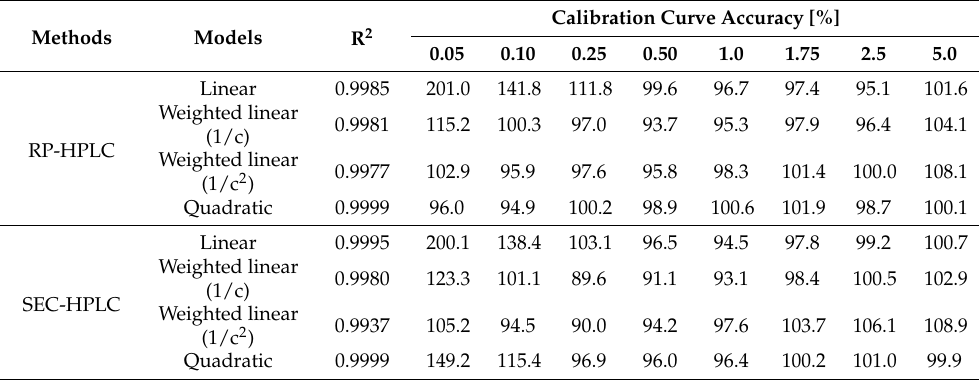
Table 2. Comparison of calibration curve models for reversed-phase (RP-HPLC) and size-exclusion (SEC-HPLC) methods.